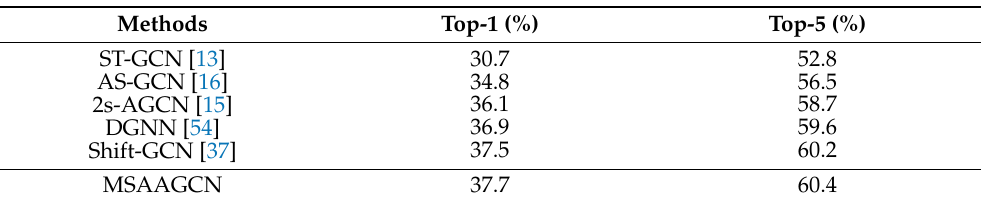
Table 7. Comparisons of the Top-1 and Top-5 recognition accuracy with the state-of-the-art methods on the Skeleton-Kinetics dataset.